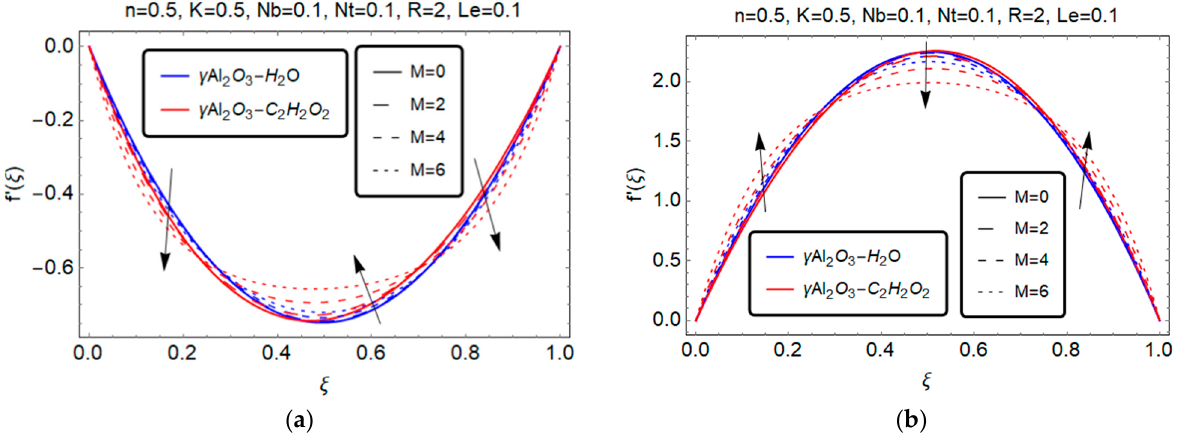
Figure 4. Effect of Hartmann number M on 𝑓′(𝜉) . ( a ) S > 0; ( b ) S < 0.